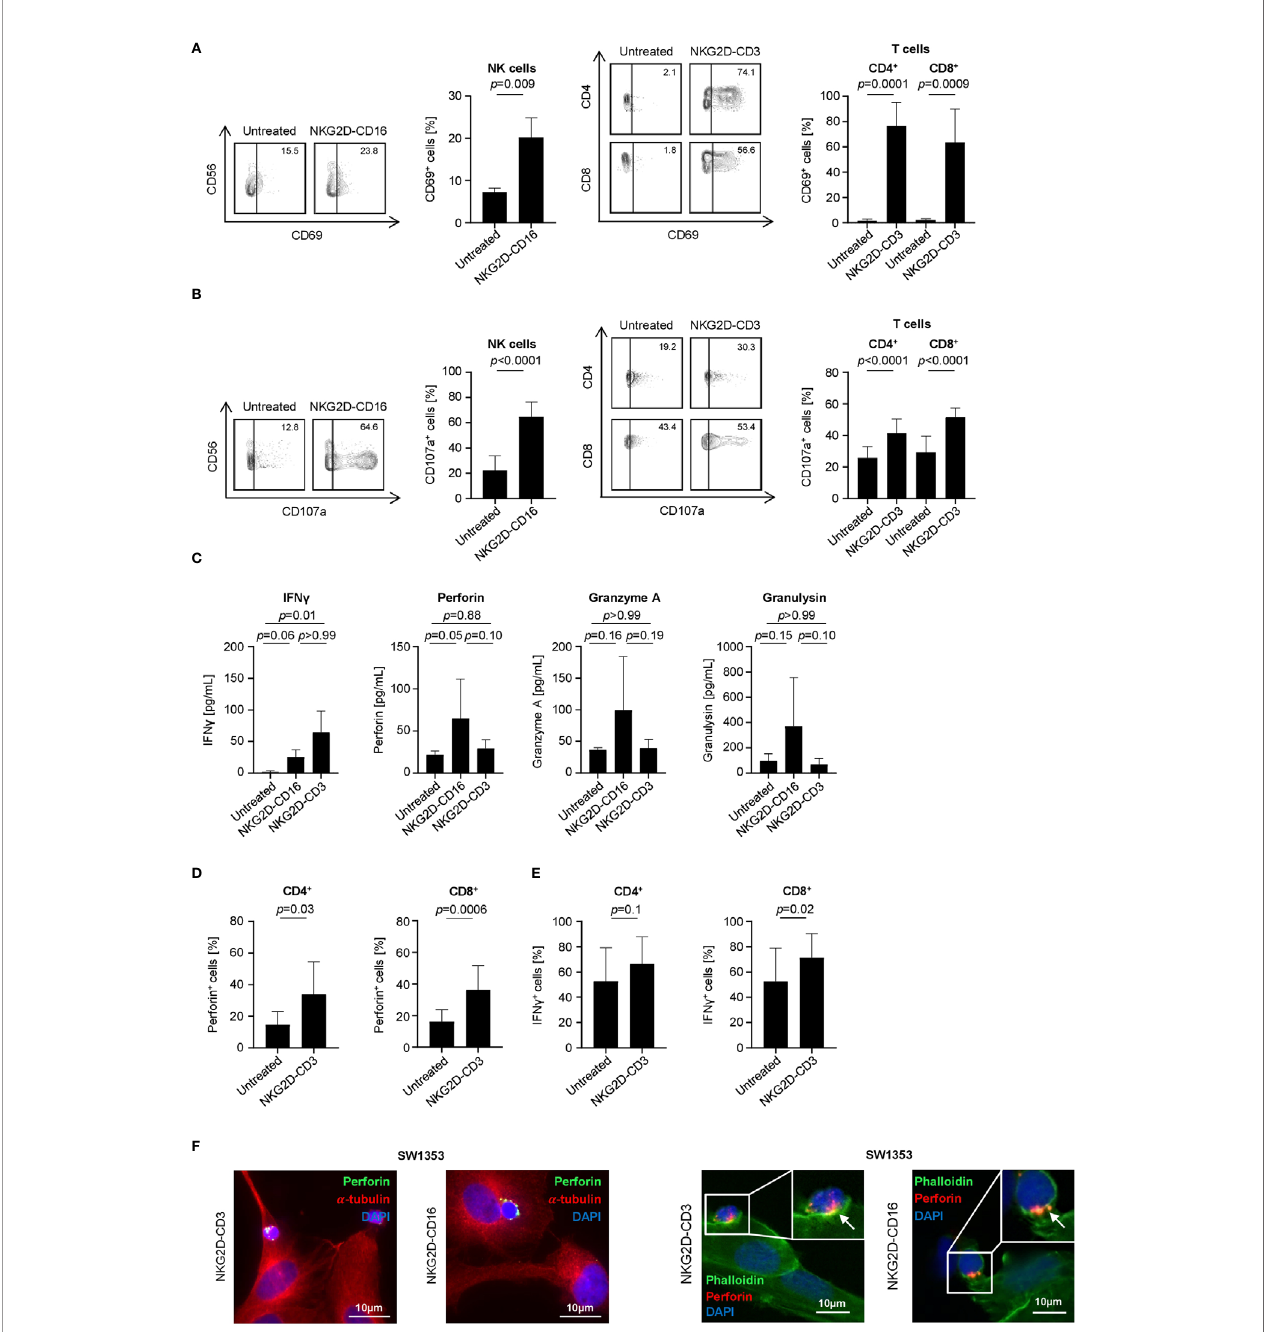
FIGURE 4 | Induction of NK and T cell reactivity by NKG2D-CD16/CD3 against sarcoma cells. PBMC of healthy donors were cultured with or without sarcoma cells at an E:T ratio of 2.5:1 in the presence or absence of NKG2D-CD16/CD3 (2.5 µg/mL). (A) Activation of NK cells and CD4 + and CD8 + T cells was determined by expression of CD69 after 24 h. In the left panels exemplary fl ow cytometry results obtained with SaOs and in the right panel combined data with sarcoma cell lines SaOs, RD-ES and SW1353 and with PBMC of 4 different donors are shown. (B) Degranulation of NK cells and CD4 + and CD8 + T cells was determined by expression of CD107a after 4 h. In the left panels exemplary fl ow cytometry results obtained with SaOs and in the right panel combined data with sarcoma cell lines SaOs, RD-ES and SW1353 and with PBMC of four independent donors are shown. (C) Supernatants were analyzed for IFN g , Granzyme A, Perforin and Granulysin after 4 h by Legendplex assays. Shown are pooled results with sarcoma cell lines SaOs, RD-ES and SW1353 and with PBMC of two independent donors. (D, E) Intracellular expression of Perforin (D) and IFN g (E) was analyzed after 24 h by fl ow cytometry. (F) Immuno fl uorescent staining was performed after 1 h (for NKG2D- CD16 treatment) and 3 h (for NKG2D-CD3 treatment). In the left panels, cells were stained for a -Tubulin (red) and the granular marker Perforin (green). In the right panels, cells were stained for actin with Phalloidin (green) and perforin